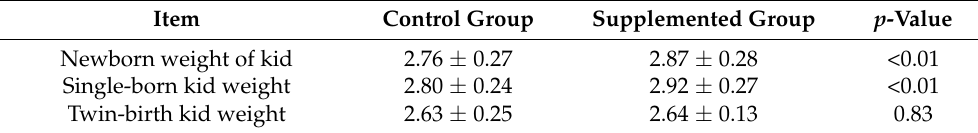
Table 7. Effect of supplementary feeding on newborn weight of kids